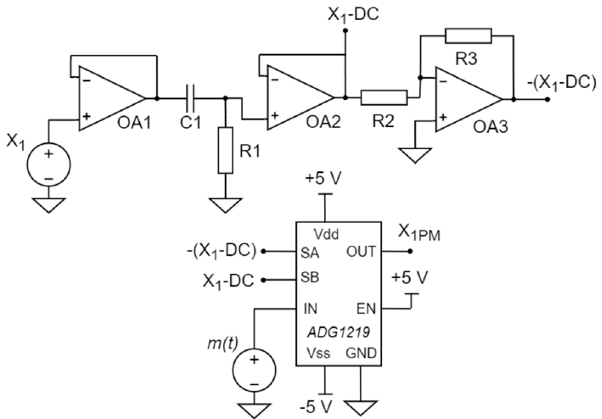
Figure 11. Chaos binary phase shifter.